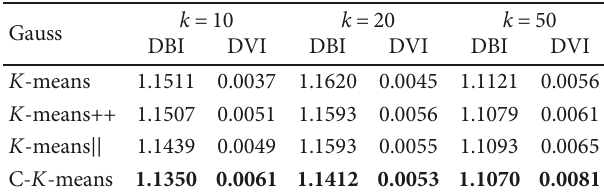
Table 6: Accuracy comparison